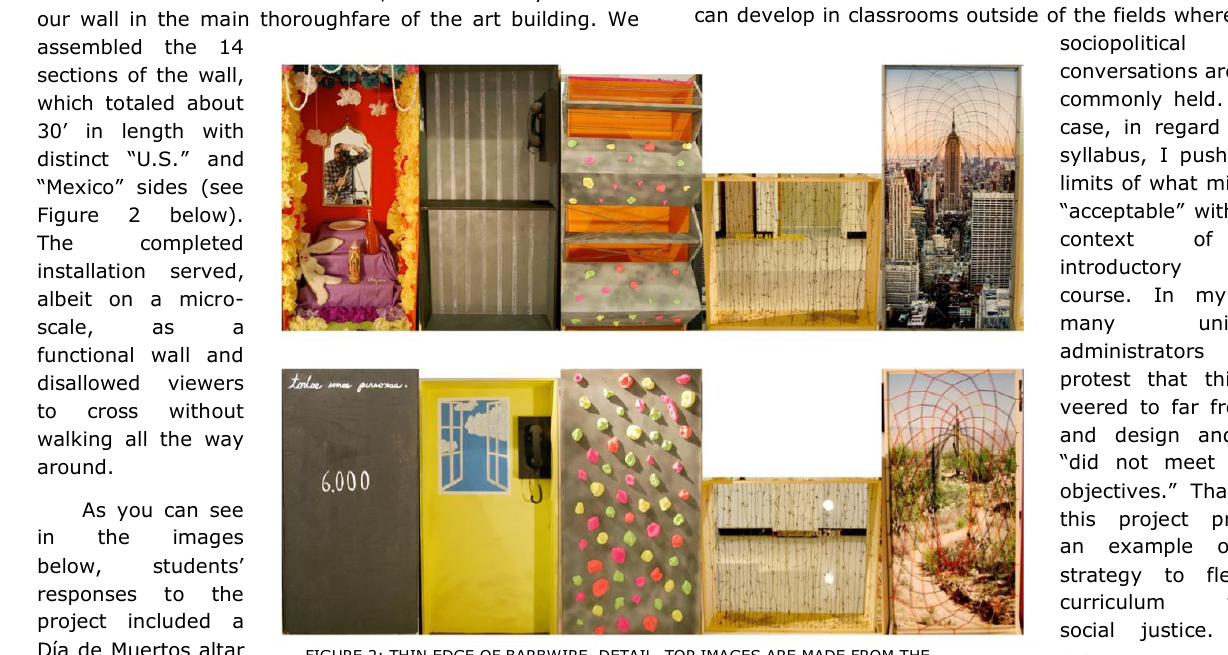
FIGURE 2: THIN EDGE OF BARBWIRE, DETAIL. TOP IMAGES ARE MADE FROM THE PERSPECTIVE OF BEING IN MEXICO, WHILE THE CORRESPONDING BOTTOM IMAGES ARE MADE FROM THE PERSPECTIVE OF BEING IN THE